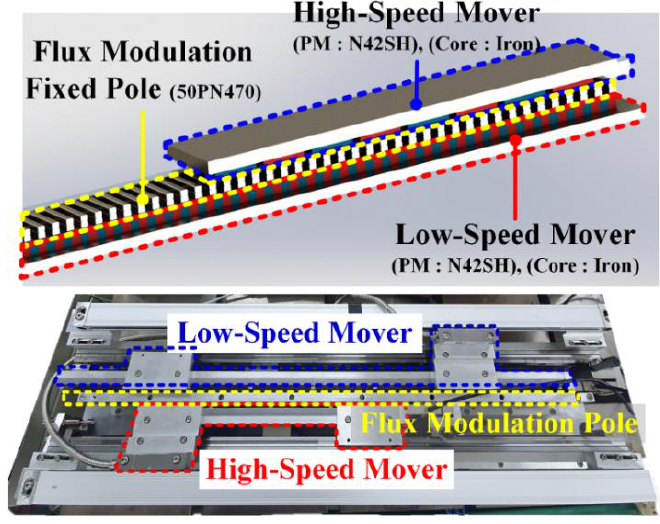
Figure 2. Structure and prototype of the linear magnetic gear. netic flux modulation fixed-pole is located between the inner and the outer movers. The flux modulation fixed-pole modulates the magnetic field by the permanent magnet of the mover and the rotating magnetic field of the flux modulation fixed-pole, to produce